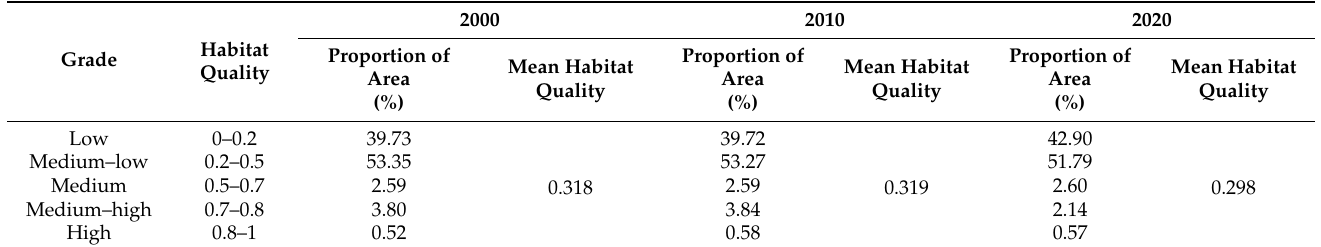
Figure 3. Spatiotemporal patterns of habitat quality from 2000 to 2020. ( a ) habitat quality in 2000, ( b ) habitat quality in 2010, and ( c ) habitat quality in 2020. Table 5. Proportion of habitat quality area of different grades in Liulin County from 2000 to